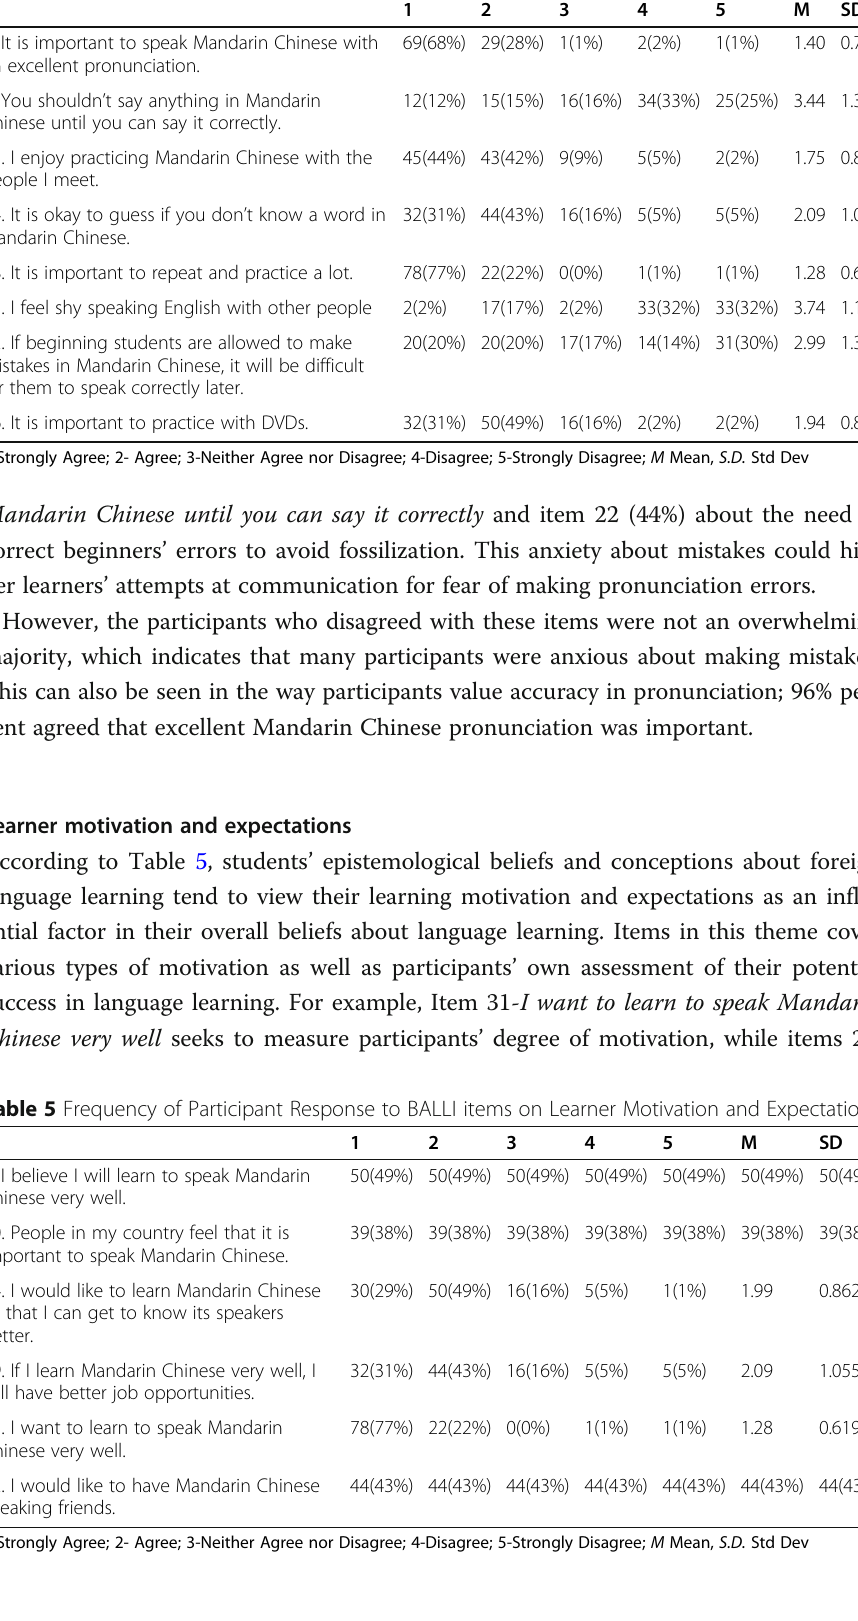
Table 4 Frequency of Participation Response to BALLI item on Strategies for Communication and Learning 1 2 3 4 5 M SD